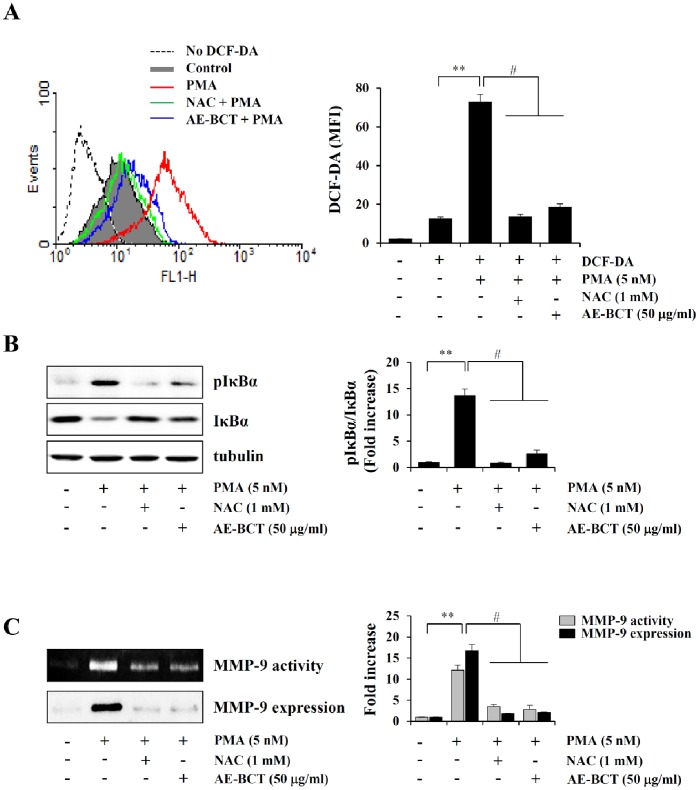
Effect of AE-BCT on intracellular ROS generation, and involvement of ROS in NF-κB activation and MMP-9 activity.(A) Cells pre-treated with NAC (1 mM) for 1 h or AE-BCT (50 µg/ml) for 12 h were stimulated with PMA (5 nM) for 3 h, incubated with DCF-DA (5 µM) for 30 min at 37°C, and then subjected to flow cytometry assay of ROS levels. Data are expressed as means ± SD of three independent experiments. **p<0.01 vs untreated control, #
p<0.01 vs PMA stimulation (B) Cells pre-treated with NAC or AE-BCT were stimulated with PMA (5 nM) for 60 min, and pIκBα and IκBα protein levels were determined by Western blotting. (C) Conditioned media collected after 24 h of PMA stimulation were analyzed for MMP-9 activity and expression. Values are expressed as fold increases in band intensity compared with untreated control cells. Data are expressed as means ± SD of two independent experiments. **p<0.01 vs untreated control, #
p<0.01 vs PMA stimulation.